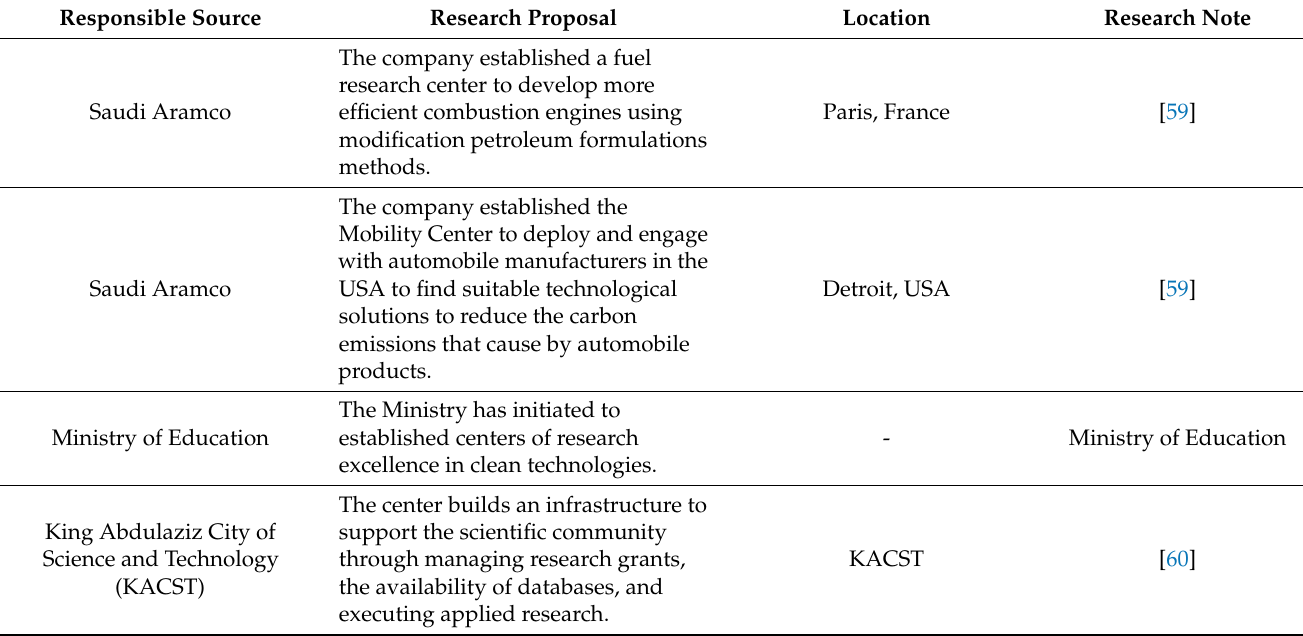
Table A3. Research and development in clean energy in Saudi